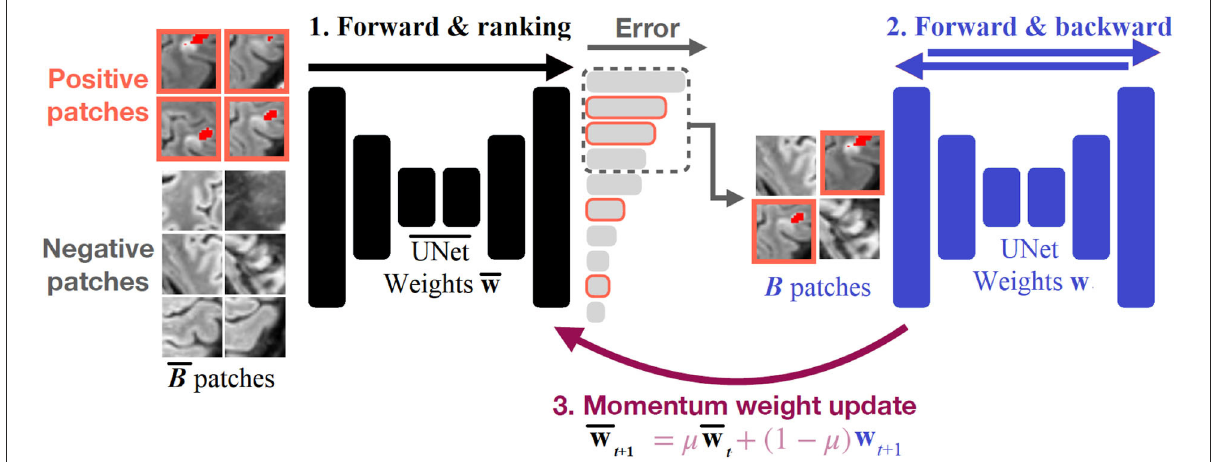
FIGURE1 Illustration of our training strategy. B patches are fed to a first 3D UNet and the segmentation errors are computed for each patch. The patches are ranked according to their errors, and the top B patches are selected to perform a training step with a second 3D Unet . The weights of the first 3D UNet are momentum-updated with the weights of the second 3D Unet .